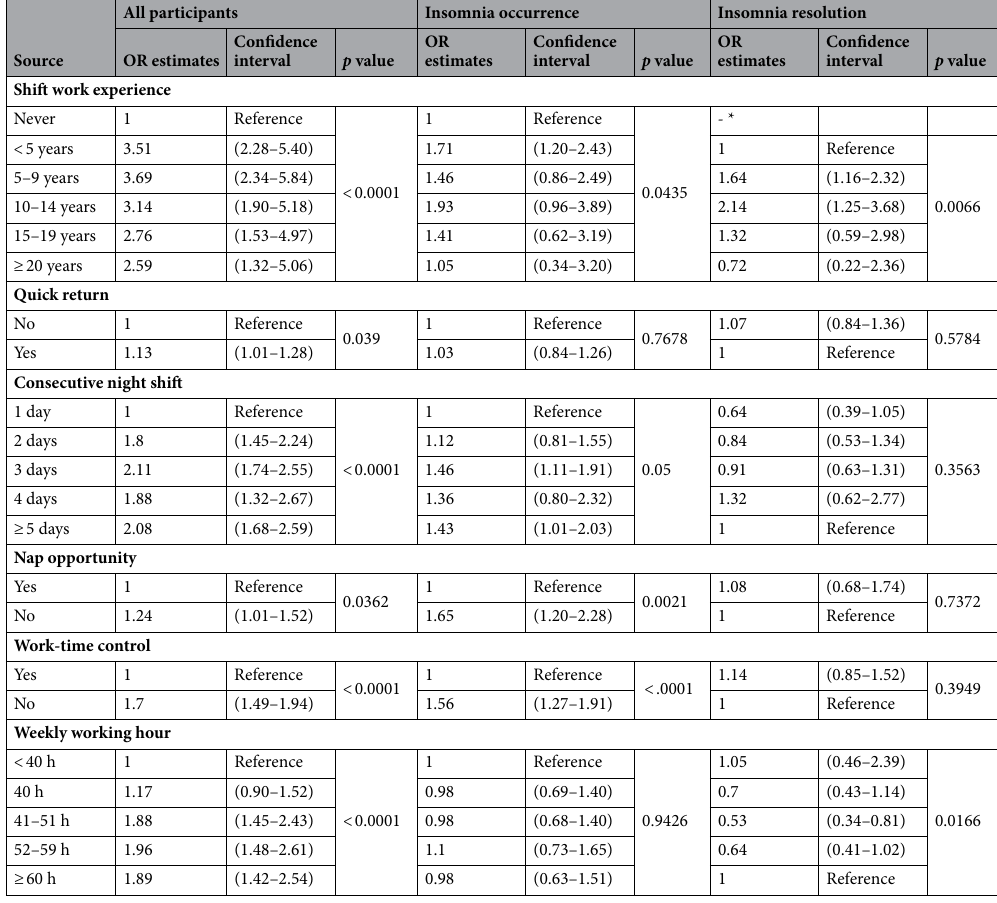
Table 3. Longitudinal effects of work organization on insomnia. The generalized estimating equation model includes age, sex, body mass index, smoking status, and drinking status as covariates. *Due to lack of power, 25 records reporting no shift work experience were not included in this